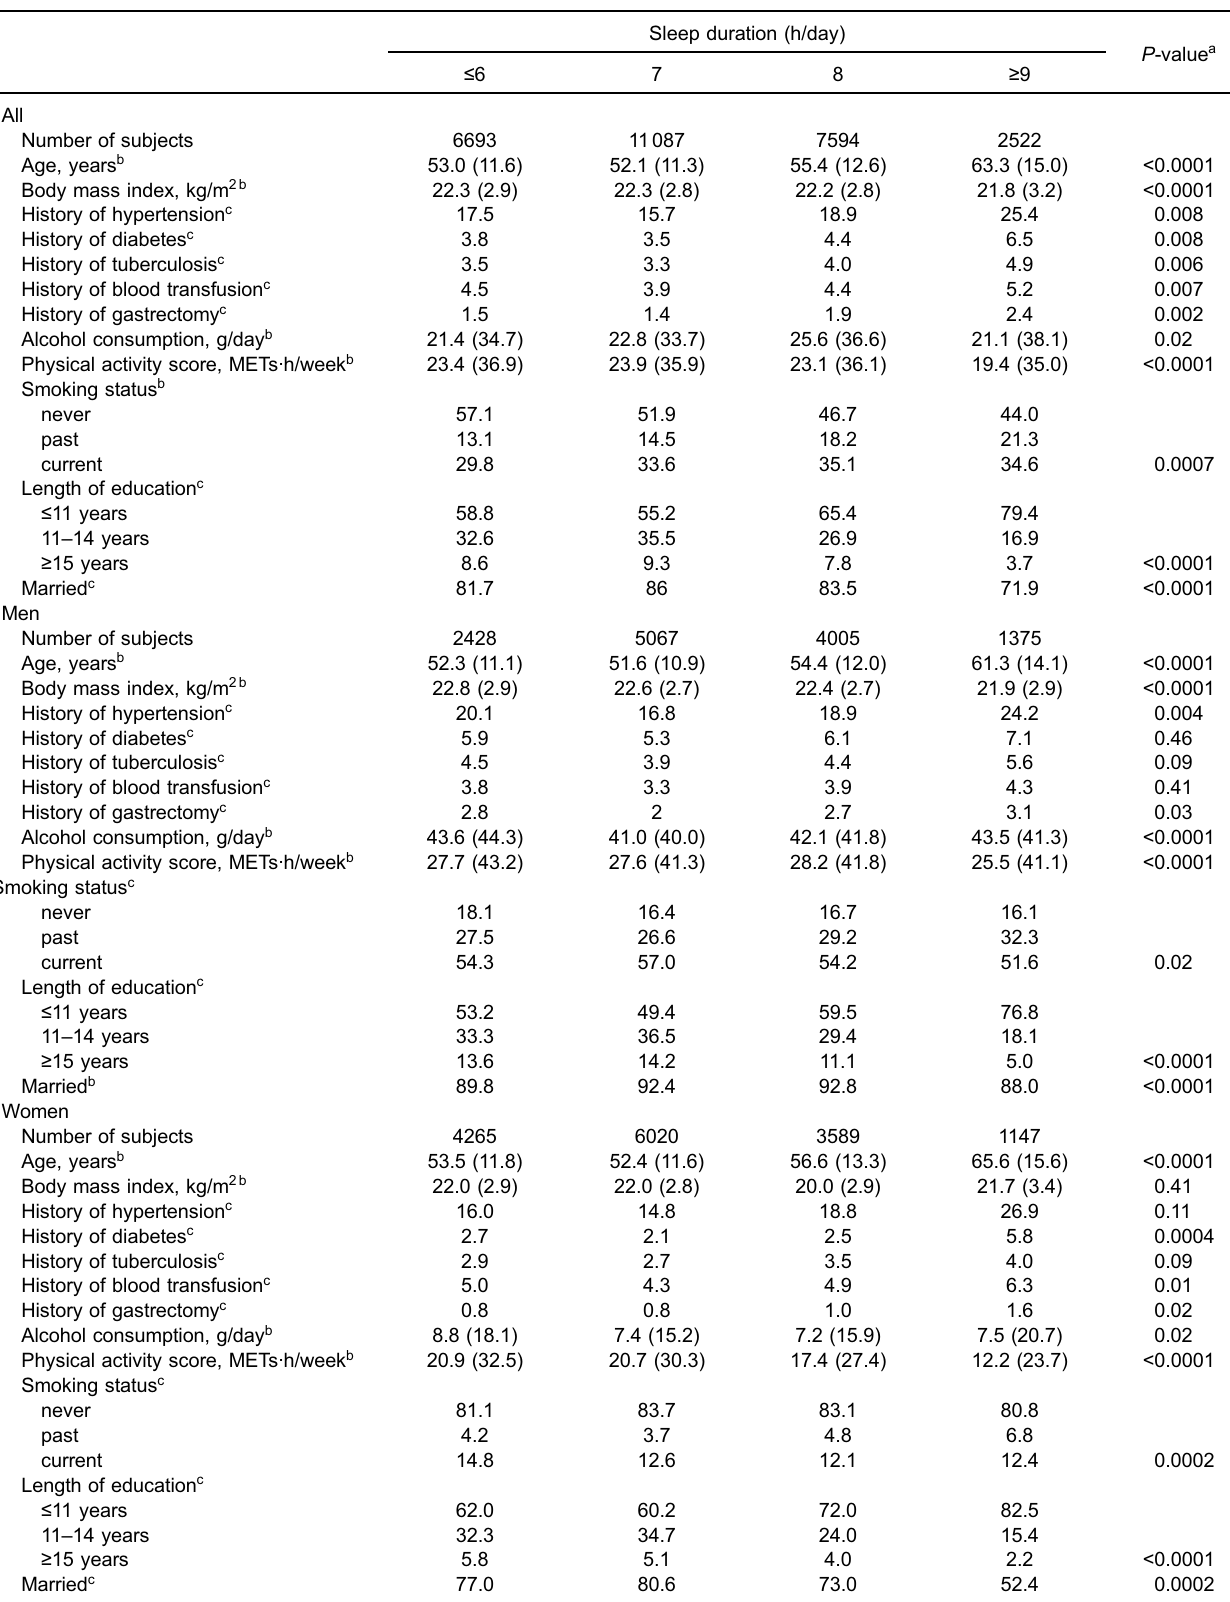
Table 1. Baseline characteristics of the study population according to sleep